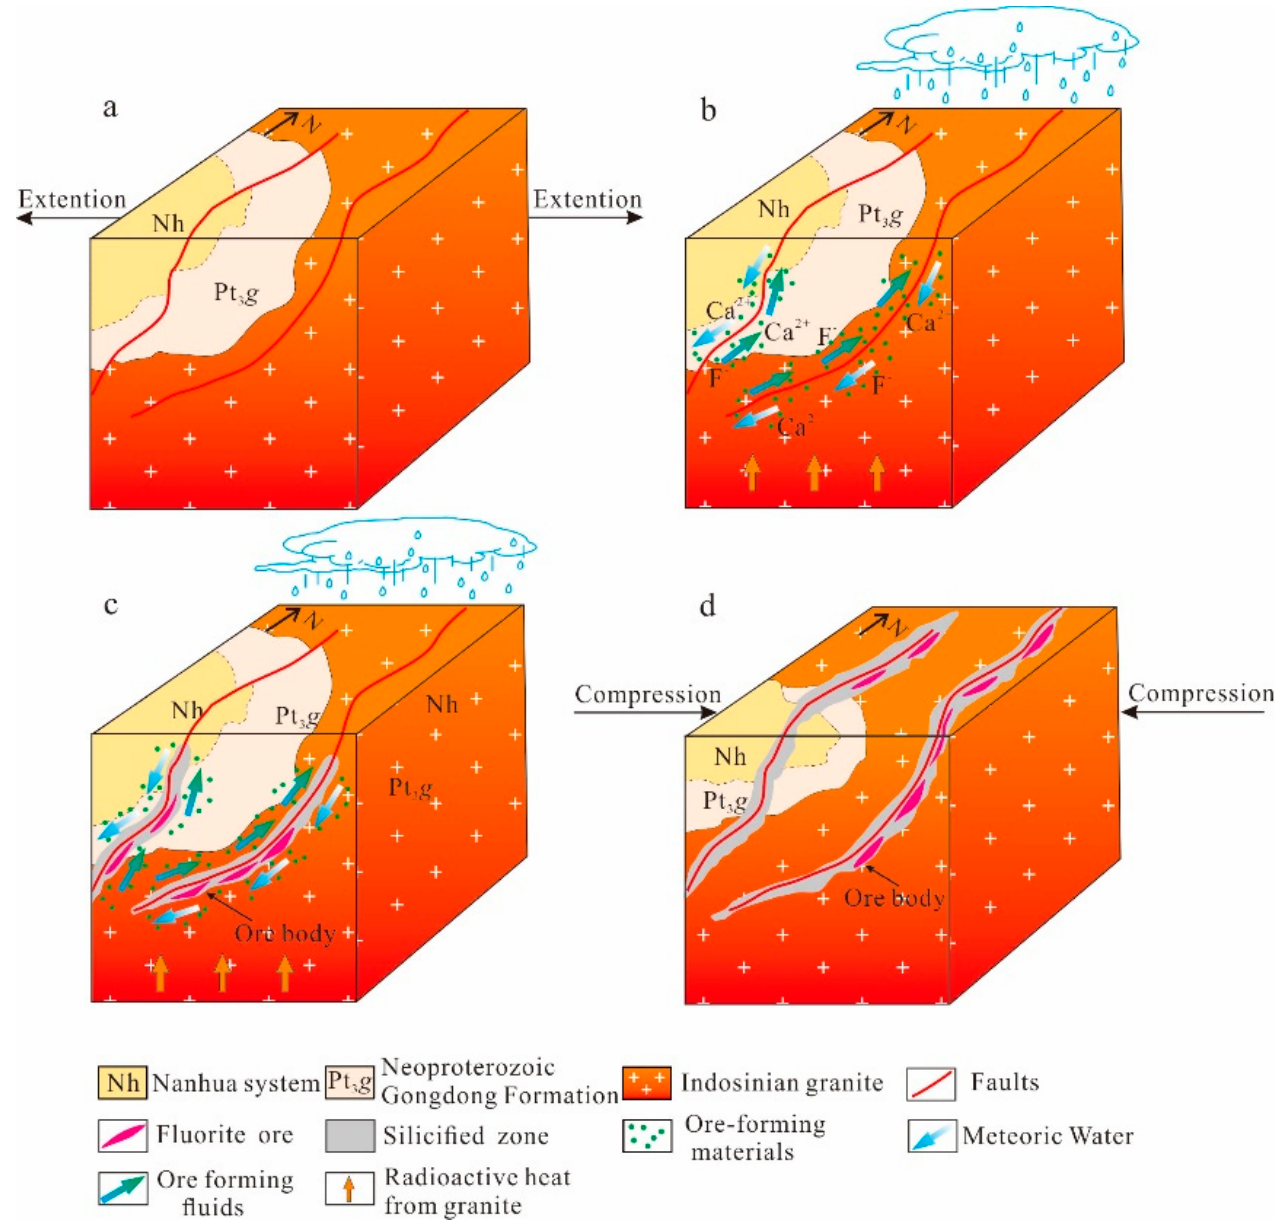
Figure 13. Schematic illustration depicting ore-forming processes of the Shuanghuajiang fluorite deposit. ( a ) the hosting Xiangcaoping granite was emplaced in Ca-rich sedimentary rocks, followed by brittle faulting of the pluton; ( b ) meteoric water percolated into the crust, which are heated by the radioactive heat from the hosting granite and ascended along the pathways provided by brittle faults, resulting in the fluids with low-T and low-salinity leaching the ore-forming materials (F and Ca) from the hosting granite and Ca-bearing sedimentary, and evolved into ore-forming fluids. ( c ) due to the changes in temperature, pressure, and pH conditions during the upward migration of the ore-forming fluids, the CaF 2 begins to precipitate and the fluorite veins were formed. ( d ) under transient tectonic compression setting, the Miaoershan region experienced compression, rapid uplift, and denudation, resulting in the exposure of some fluorite orebodies in the Shuanghuajiang fluorite deposit.